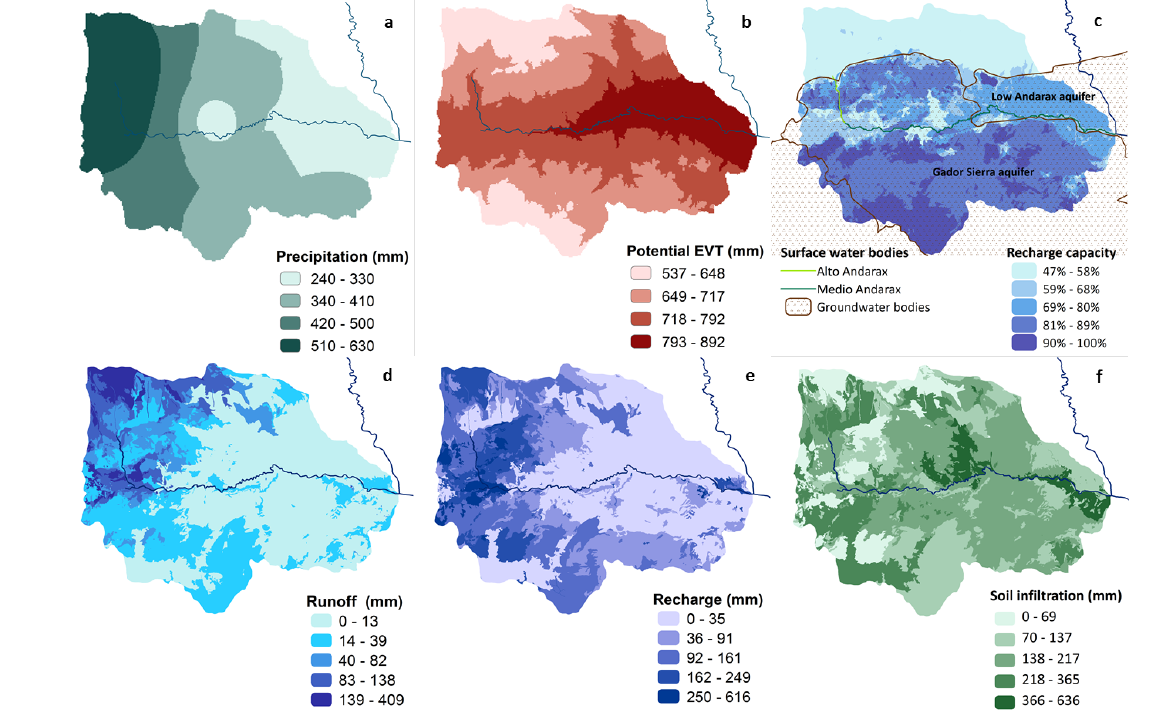
Fig. 5 . Spatial distribution of (a) median annual precipitation; (b) potential evapotranspiration; (c) recharge capacity; (d) soil infiltration; (e) runoff; (f) recharge.